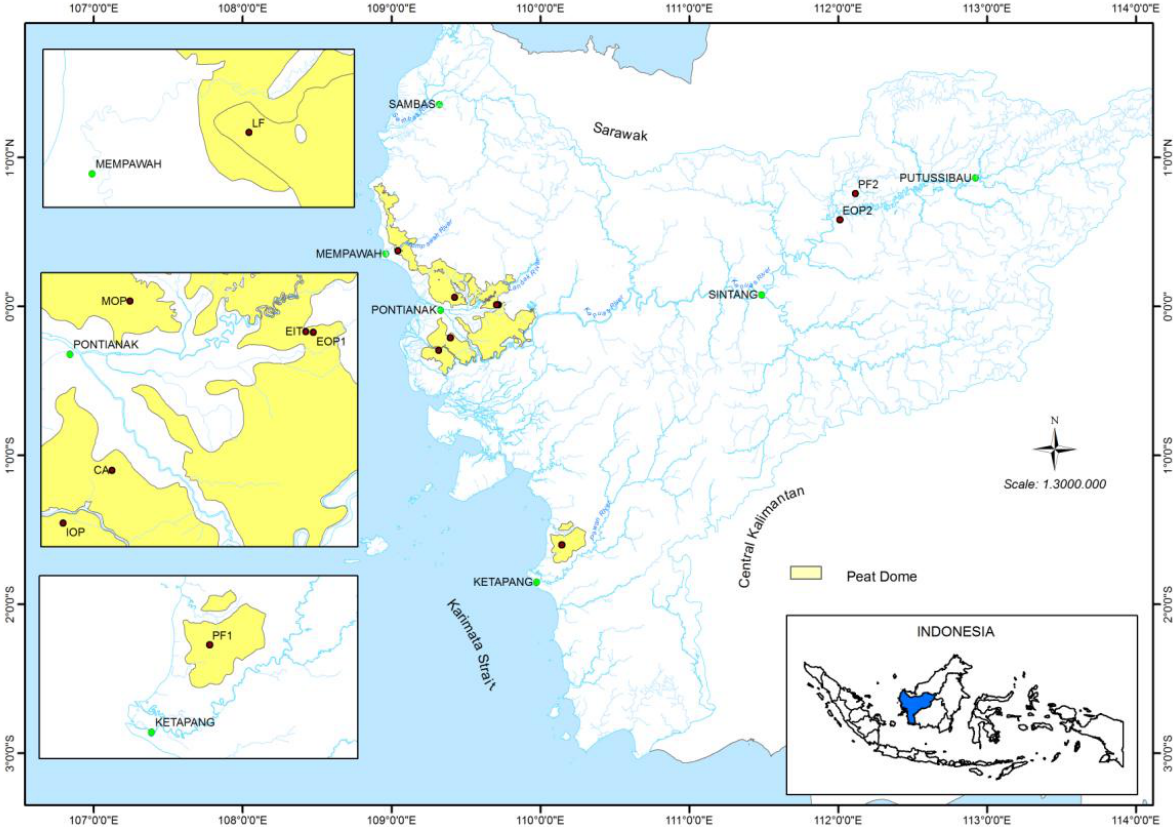
Fig. 2. West Kalimantan Province, showing study sites in selected coastal peat domes and two sites in inland peats.